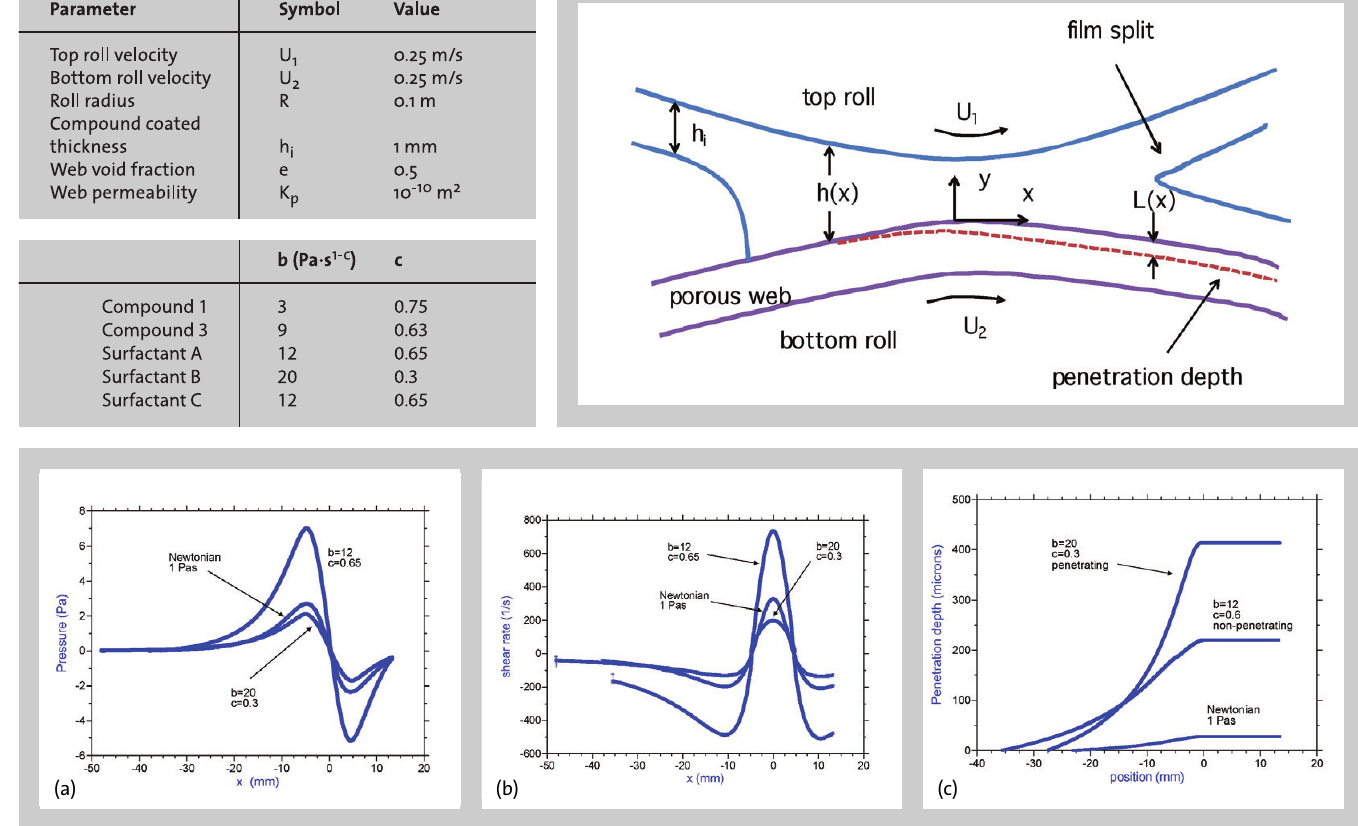
Figure 2 (above): Enlargement of the nip geometry of interest with the web following the bot- tom roll and the coating material coming in to the nip on the top roll from left to right. A puddle of the coating material exists upstream (denoted h(X)), on the left, and a thin film is applied onto the moving web after film split. Figure 3 (below): Model predictions of (a) pressure, (b) shear rate, and (c) penetration for a Newtonian fluid and two shear thinnig compounds Table 1 (above): Process parameters used in the working model. Table 2: Power-law parameters for experimental